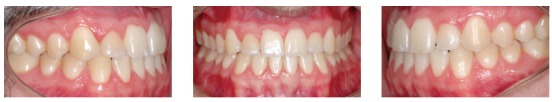
1-year post-treatment intraoral photographs.